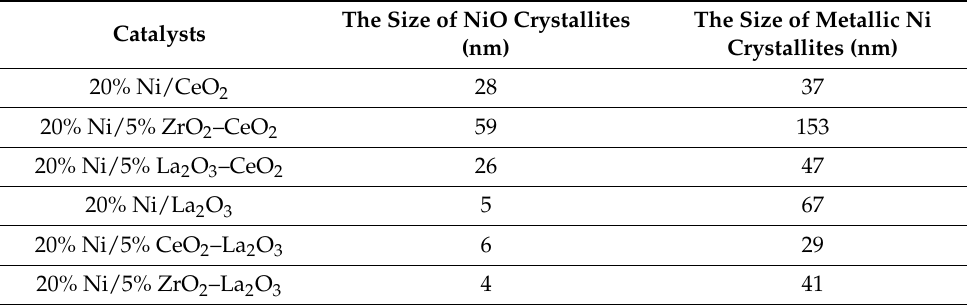
Table 3. The sizes of the NiO and metallic Ni crystallites, calculated based on the XRD measurements of calcined and spent Ni catalysts in the OSR of